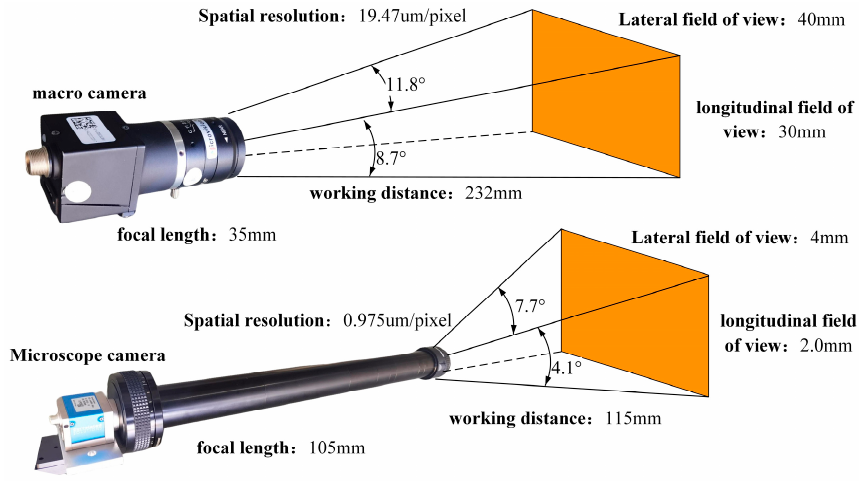
Figure 7. Camera Figure 7. Camera parameters.